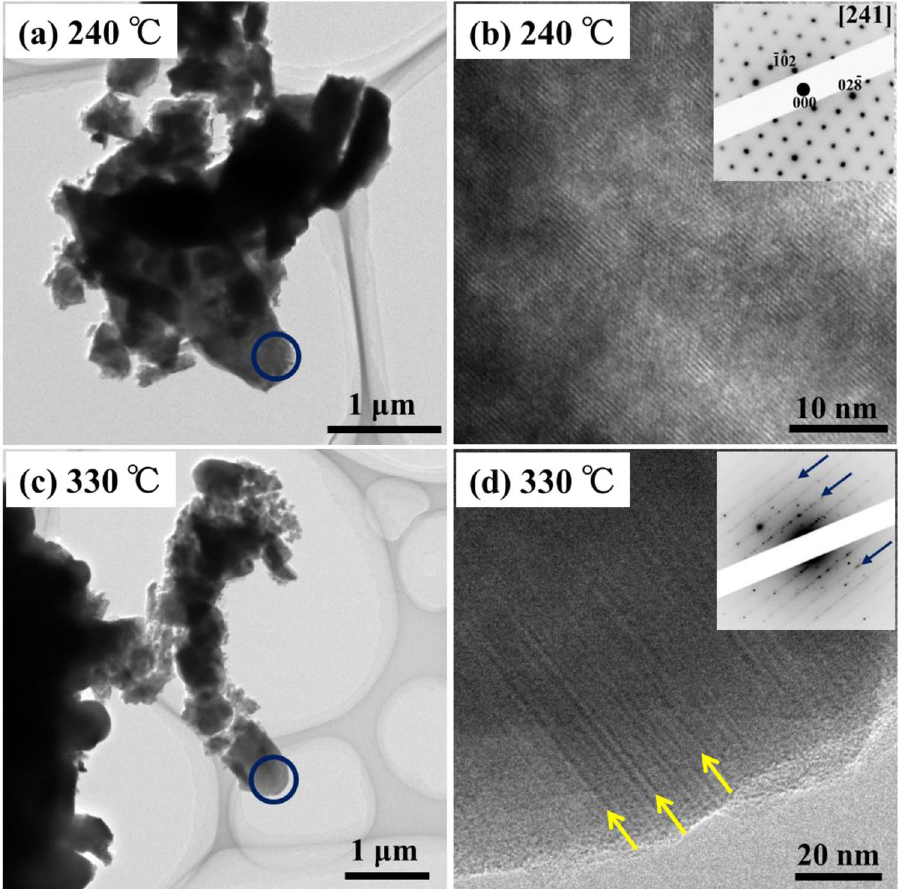
Figure 4. Ex situ TEM measurements of the charged NMC composites with the EC/EMC solution. The BF images in ( a , c ) show the morphology of the NMC composites after heating at 240 °C and 330 °C, respectively. The HR images in ( b , d ) show the microstructure in NMC after heating at 240 °C and 330 °C,